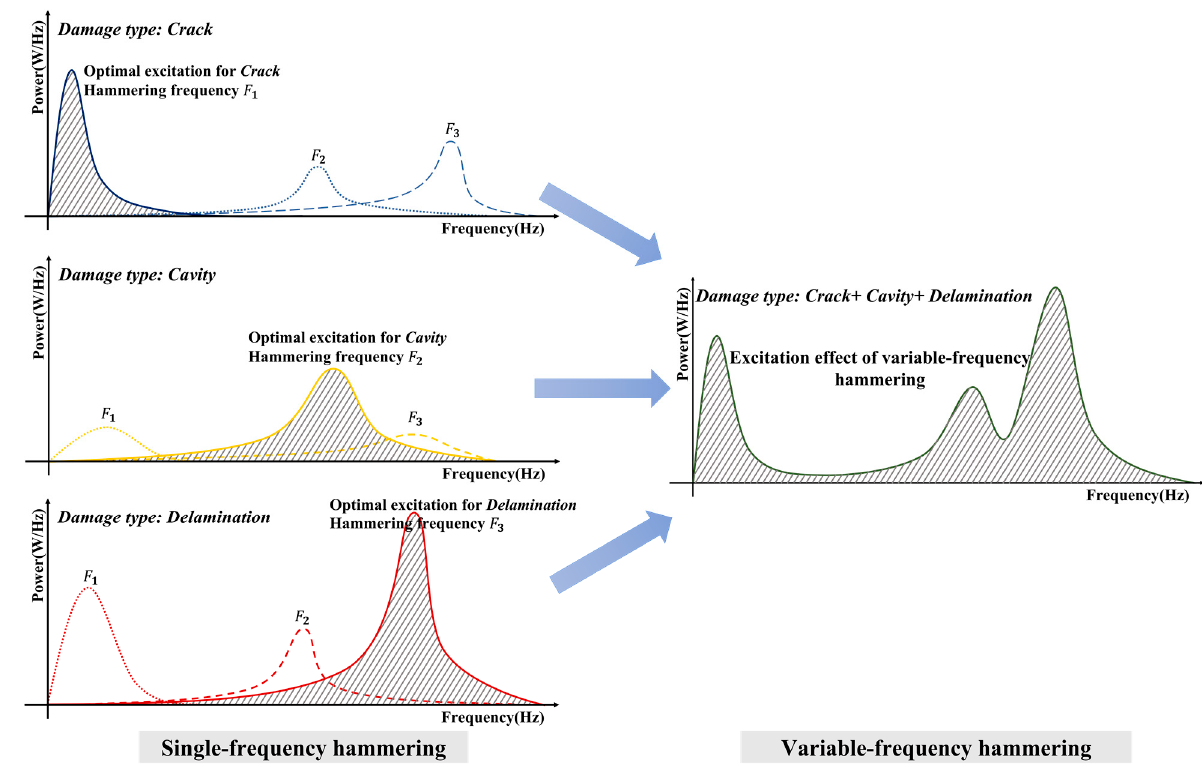
Figure 1. Schematic diagram of the excitation effect under different hammering methods.